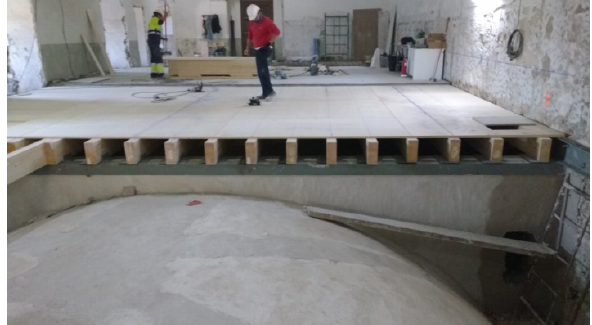
Figure 3: Reinforcement on wall ribs